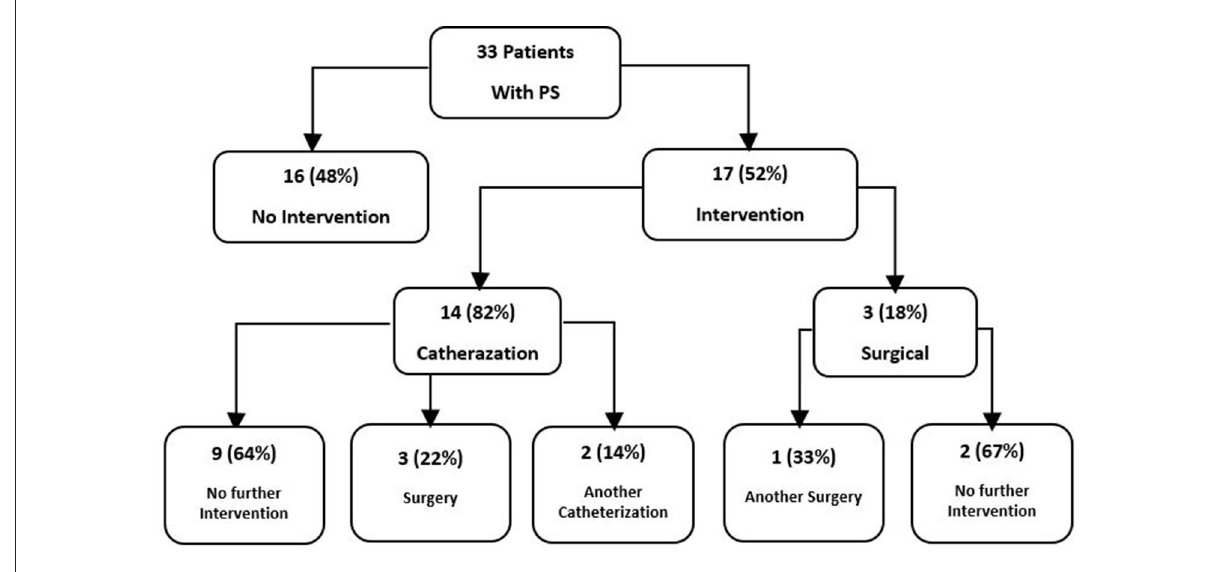
FIGURE1 Intervention in 33 Noonan patients who has PS.